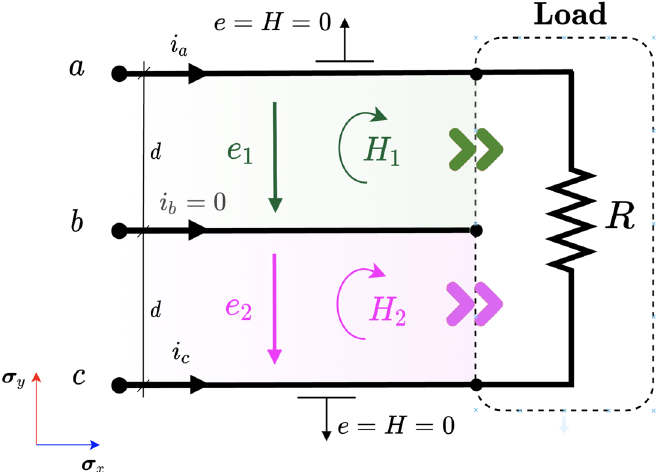
Figure 3. Magnetic and electric field in a 2D circuit with unbalanced three-phase load and symmetrical